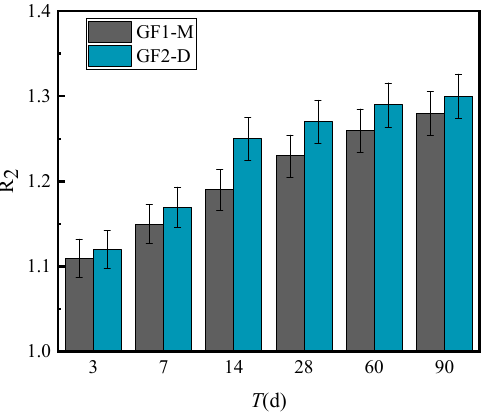
Figure 9. Splitting strength ratio of VGM-30 and general gradations.